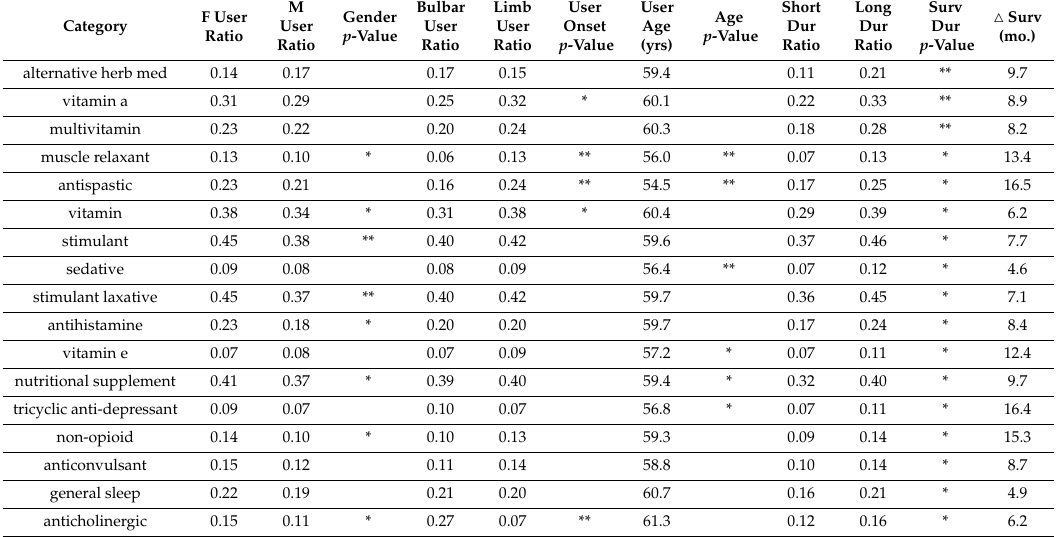
Table 4. Pharmaceutical medications and supplements with a significant association with longer survival